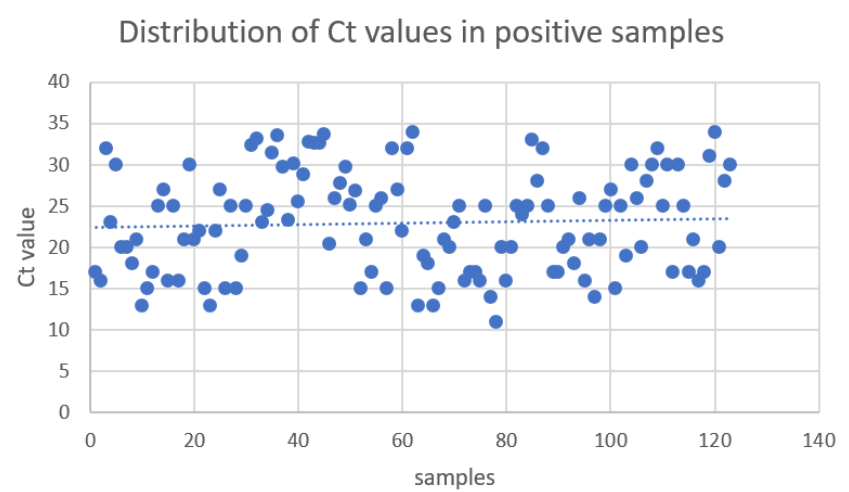
Figure 1. Distribution of Ct values of positive samples.